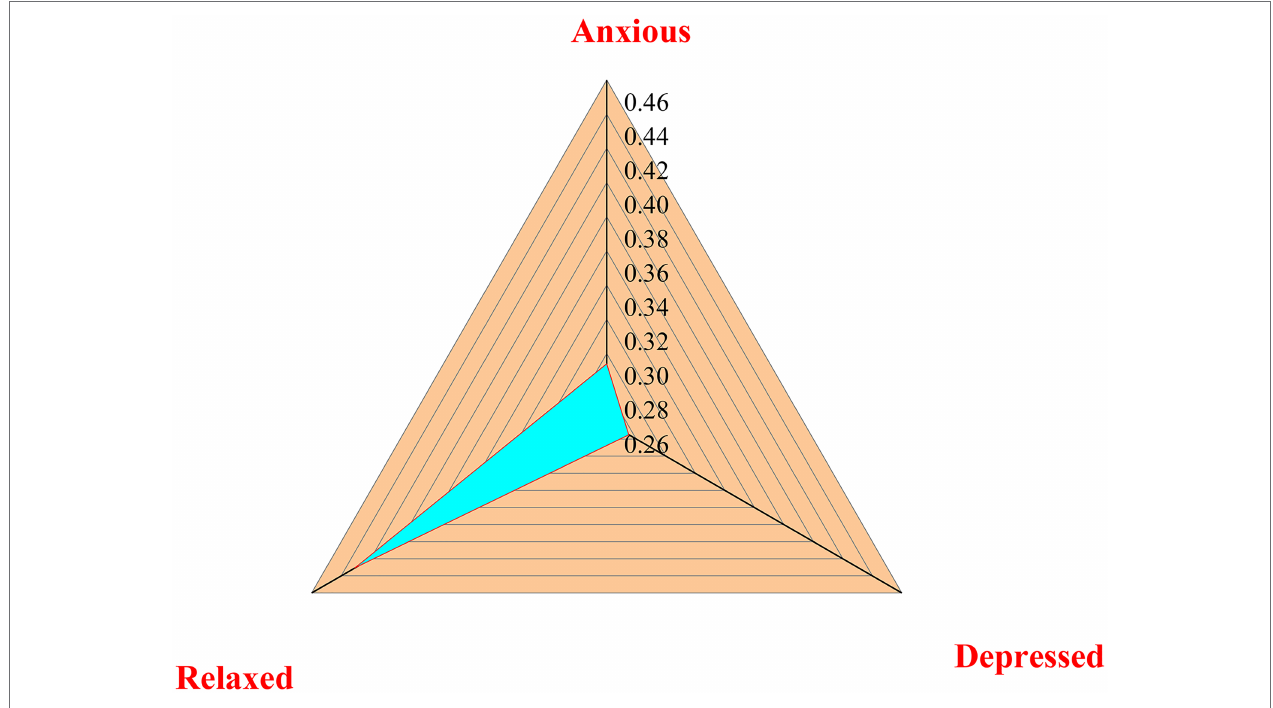
FIGURE 7 | Analysis of mental health of young